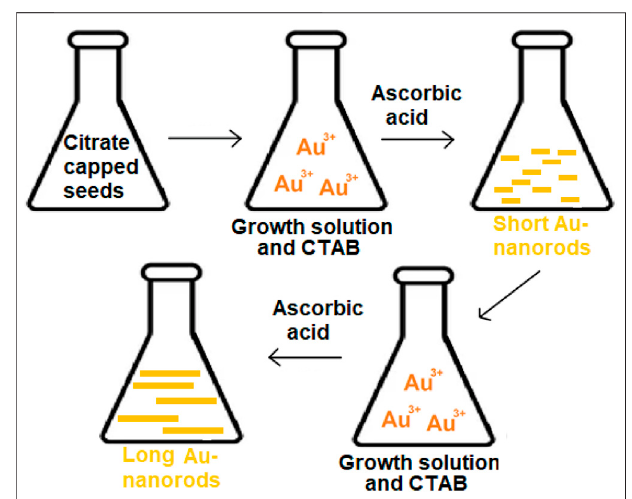
FIGURE 3 | Schematic representation of seed mediated growth of AuNPs: long nanorods and short nanorods.